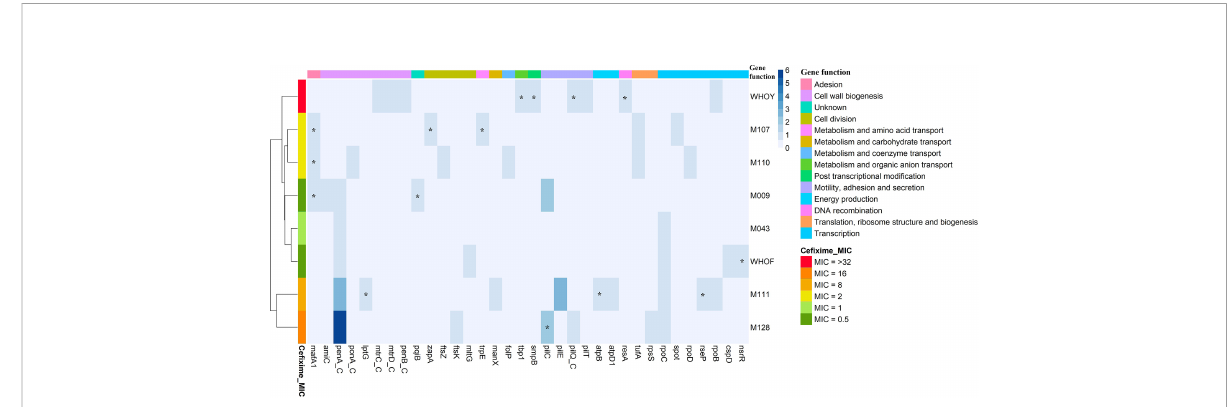
FIGURE 2 Heatmap of mutations in known coding sequences in Neisseria gonorrhoeae isolates after selection for resistance to ce fi xime and description of affected gene functions. Isolates and genes are presented in rows and columns, respectively. The blue color scale represents the amount of acquired mutations. The left sidebar represents the minimum inhibitory concentration (MIC) of ce fi xime (mg/L). The top bar indicates the function of each gene. _C indicates determinants related to extended-spectrum cephalosporin resistance; asterisk indicates genes that showed a